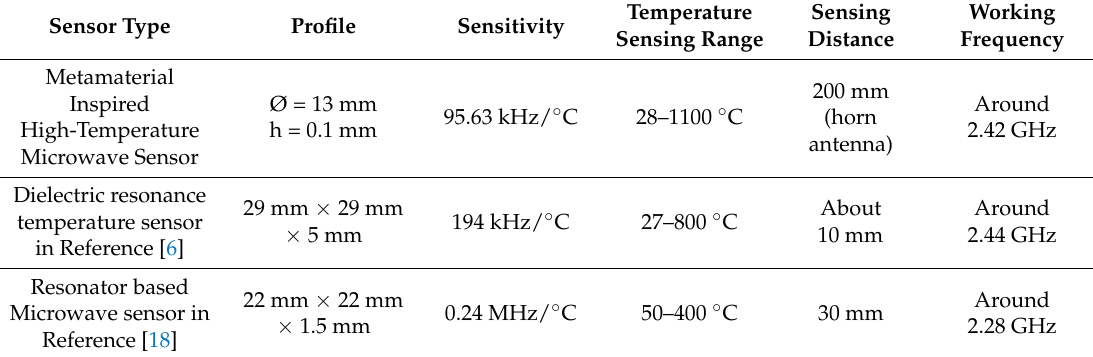
Table 3. Parameters of different temperature